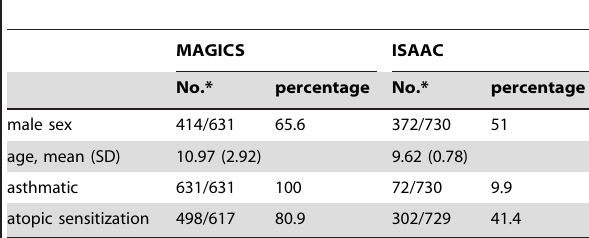
Table 3. Characteristics of the population used for the actual study consisting of two parts, the Multicentre Asthma Genetics in Childhood Study (MAGICS) and the International Study for Asthma and Allergies in Childhood